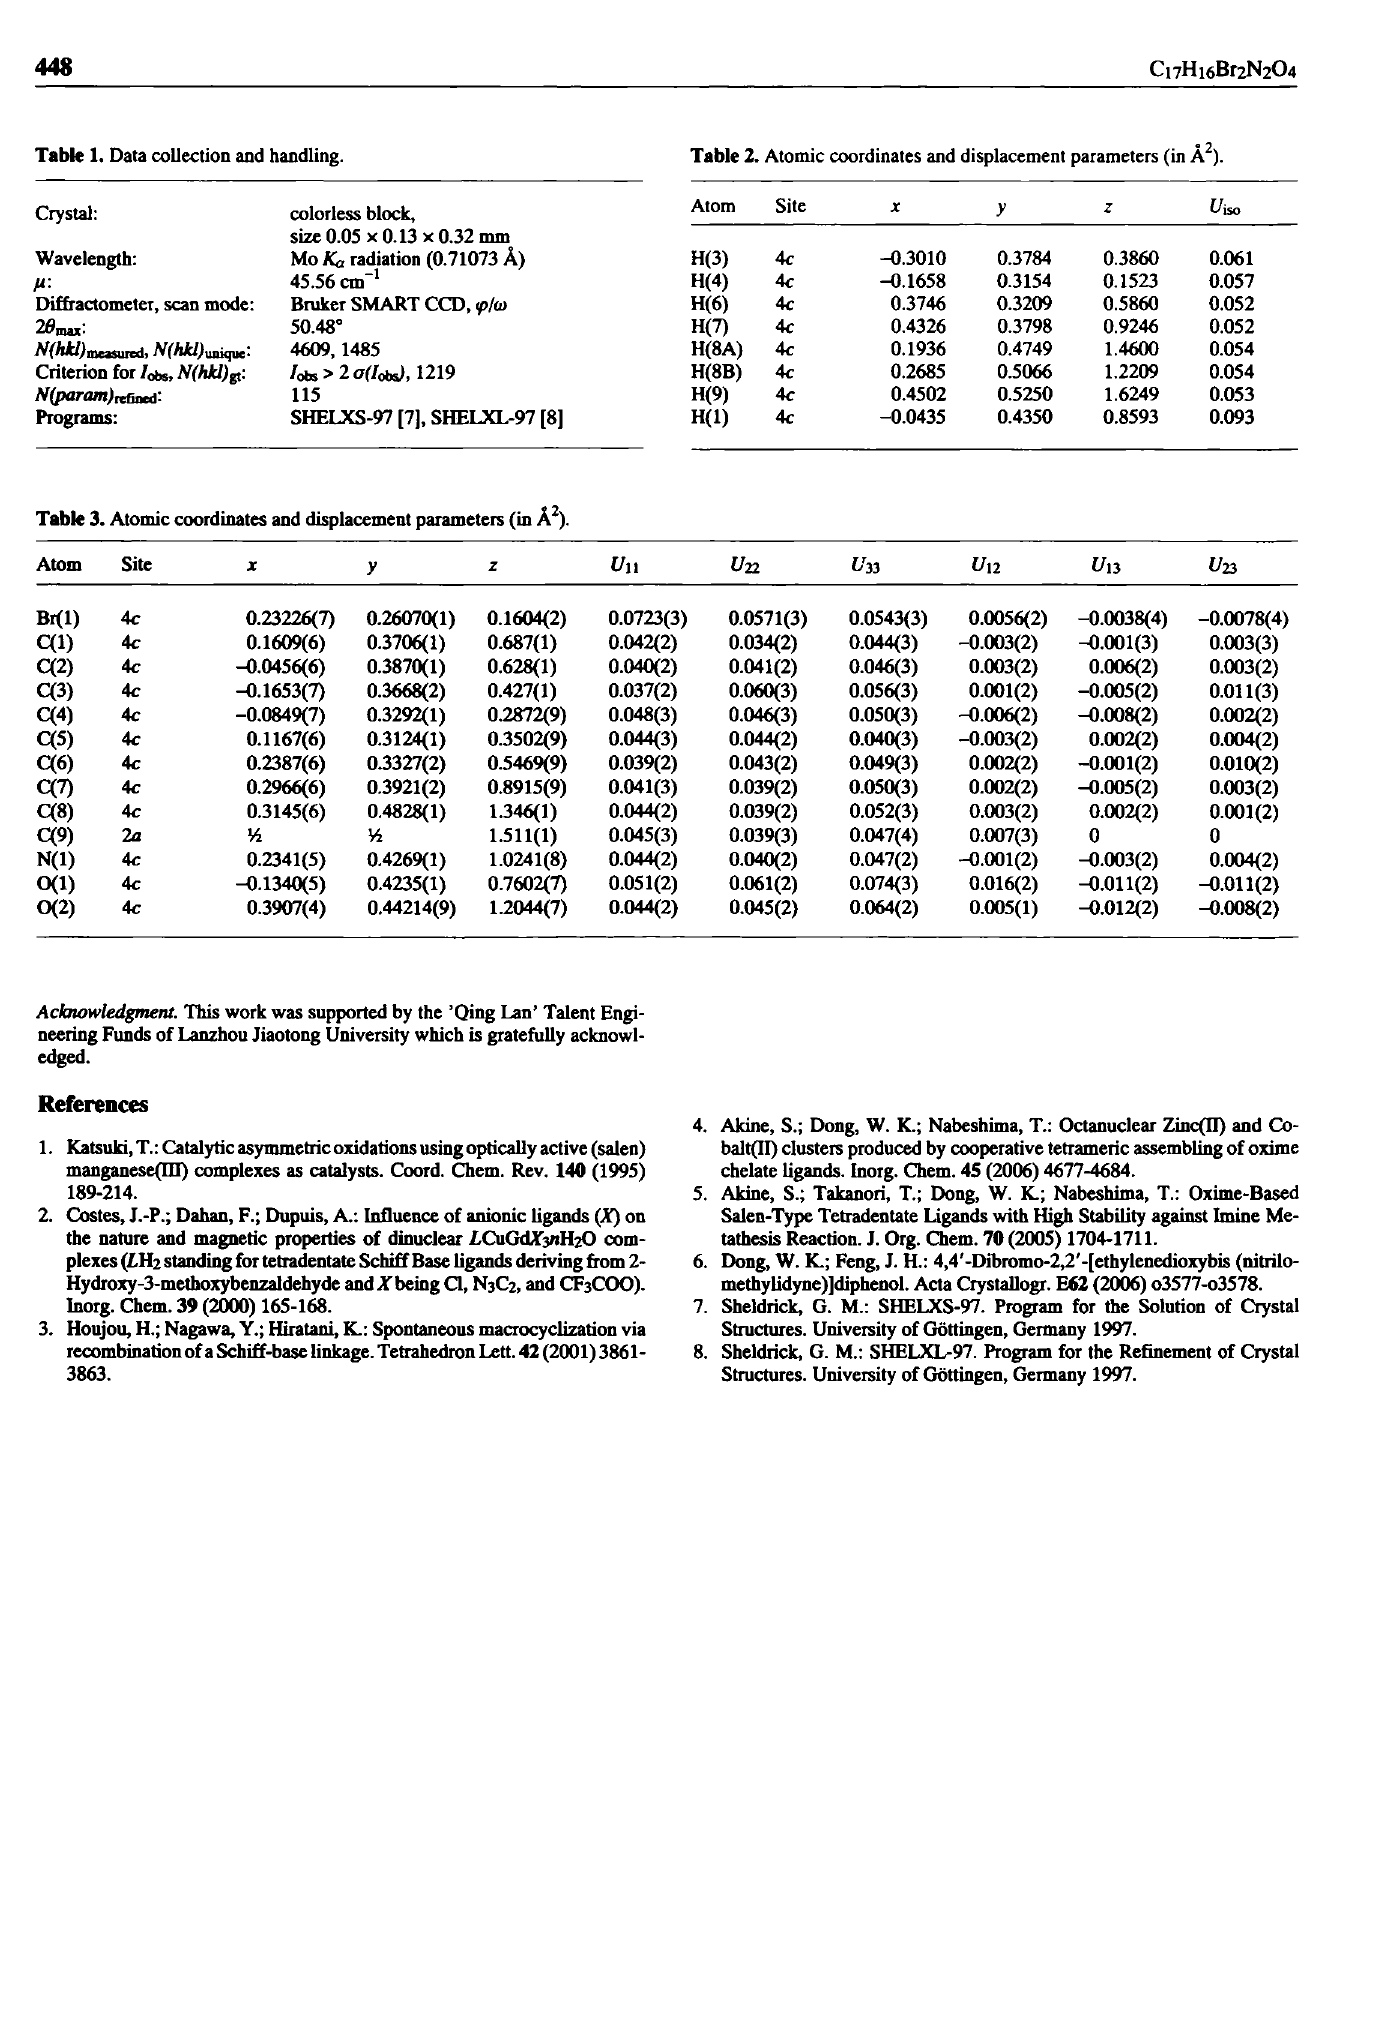
Table 1. Data collection and handling. Table 2. Atomic coordinates and displacement parameters (in Ä 2 ).